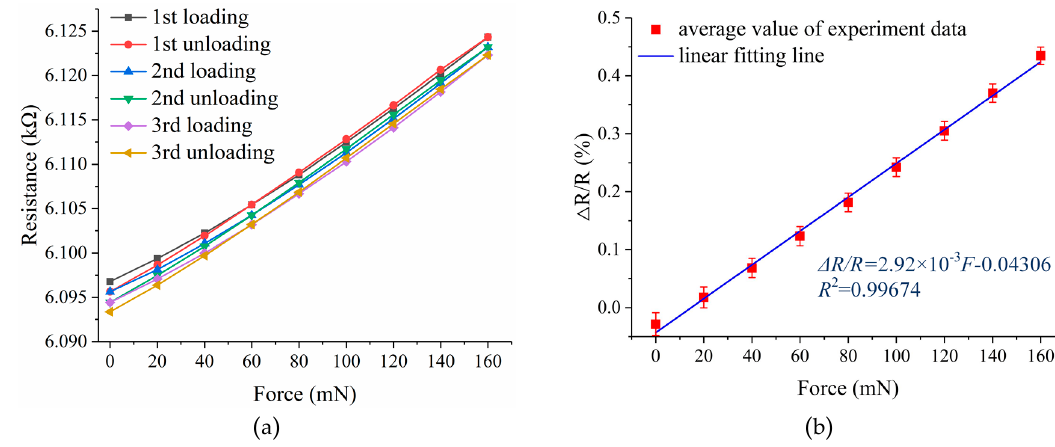
Figure 14. ( a ) The resistance change versus applied force; ( b ) the least square fit of experimental data.